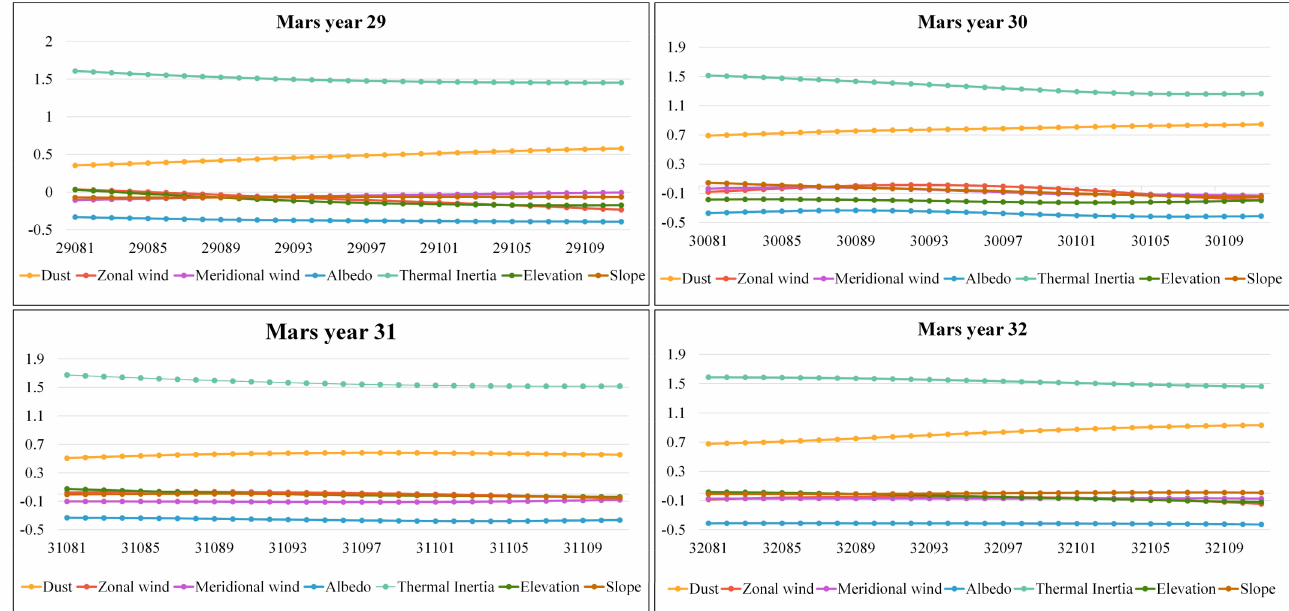
Figure 9. The temporal trend in the coefficient of independent variables for SAT based on the GTWR model during 81–111 sol from Martian years 29 to